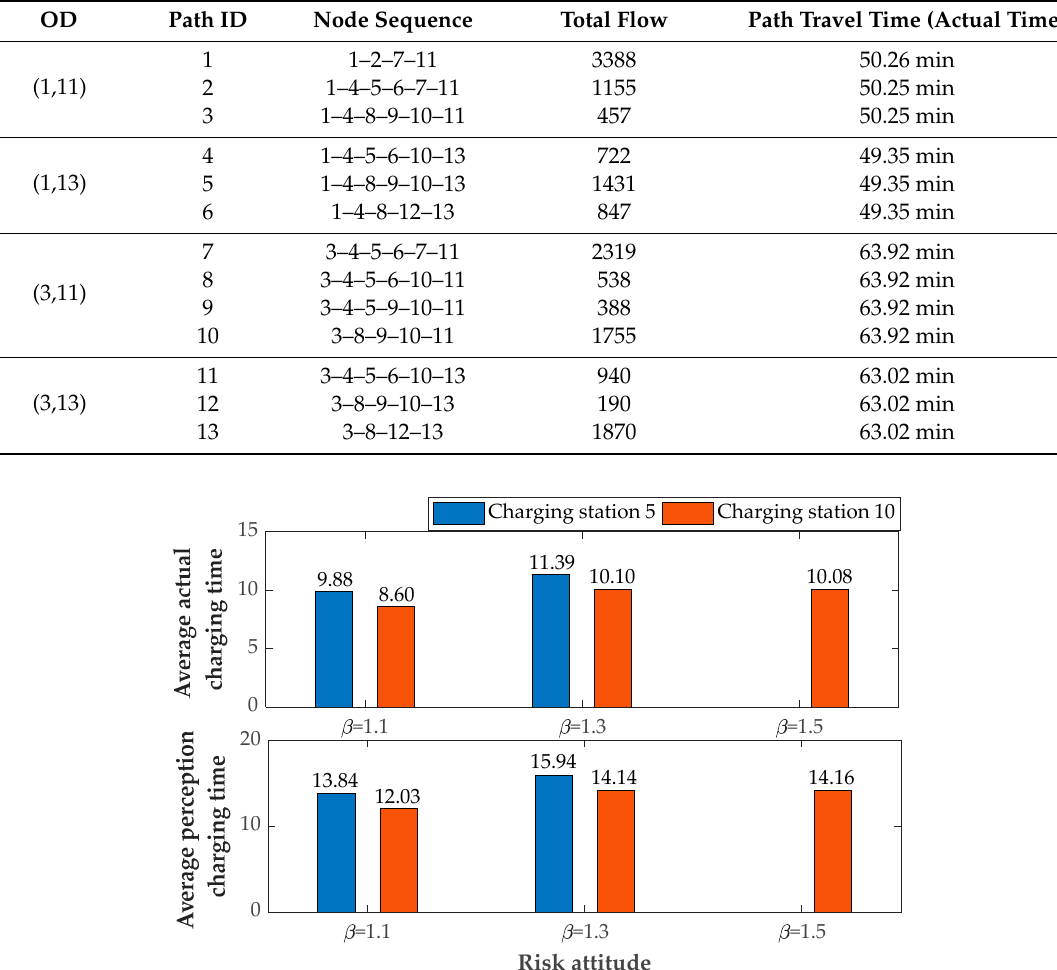
Figure 6. Recharging time information (without the battery safety margin).